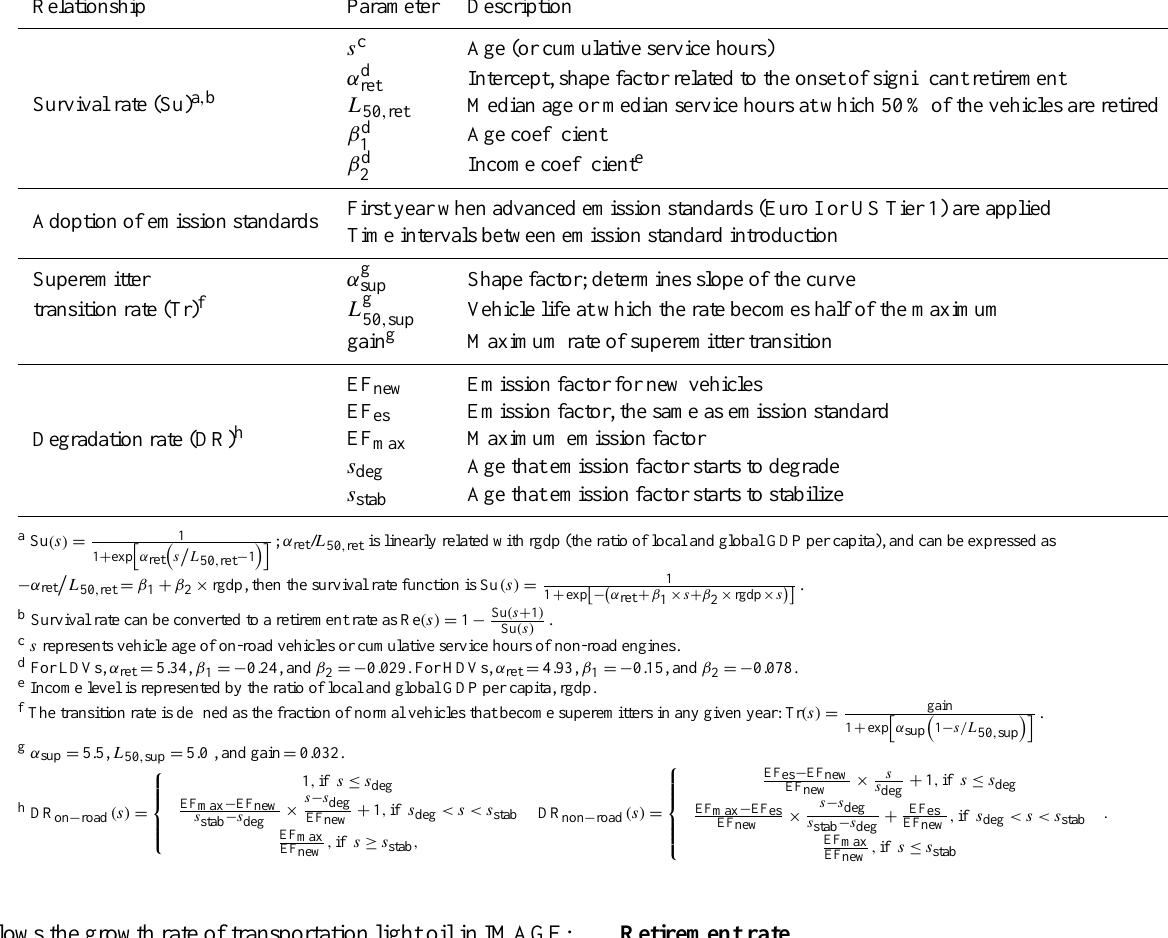
Table 1. Relationships and parameters used in the SPEW-Trend model for on-road vehicles and non-road engines. Relationship Parameter